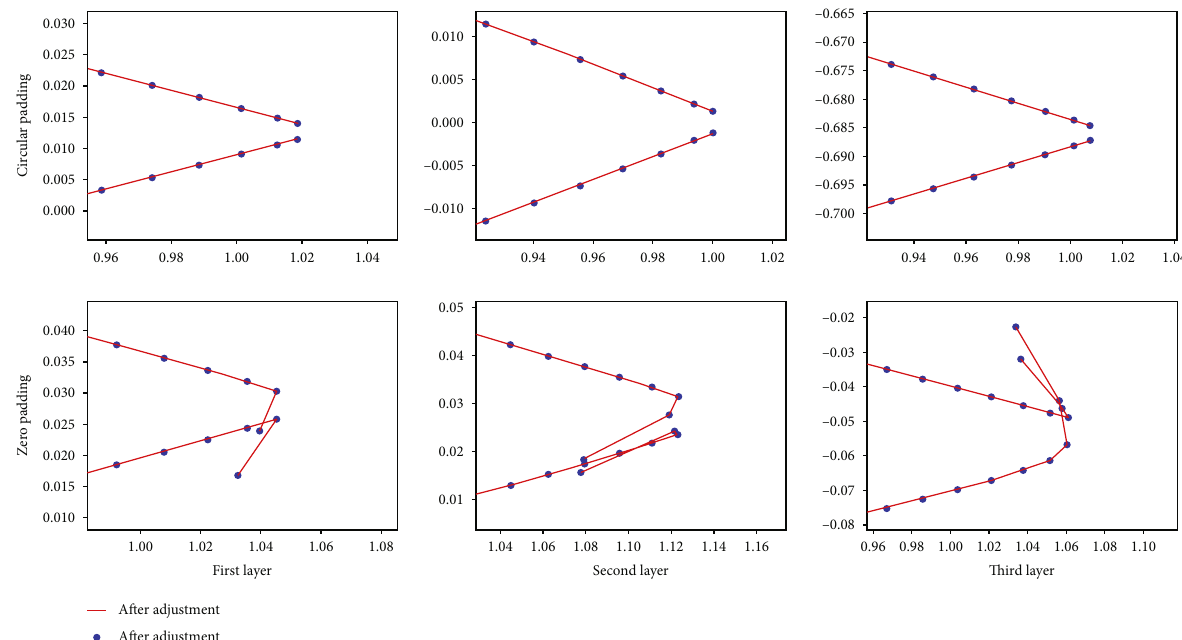
Figure 11: Wing tail adjustment under di ff erent padding modes.